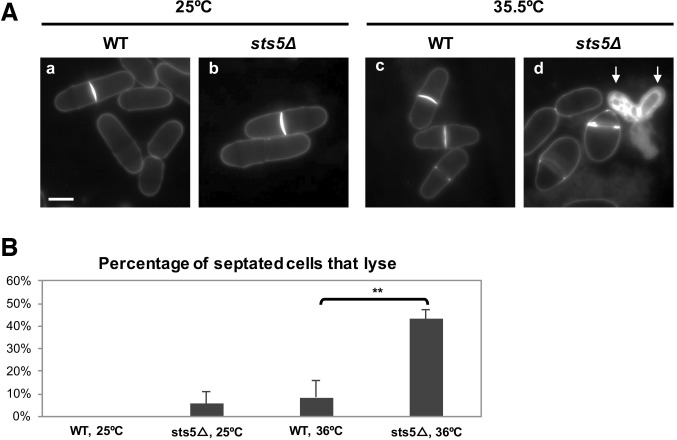
sts5∆ cells display increased cell lysis during cell separation.(A) sts5∆ cells display increased cell lysis during cell separation (d) at the restrictive temperature (35.5°C). Arrows indicate sister cells that have lysed. (B) Quantification of the percentage of septated cells that lyse in WT and sts5∆ cells at 25°C and 35.5°C. Quantification based on 3 independent experiments. Percentage of septated cells that lyse is significantly greater in sts5Δ cells as compared to controls at 35.5°C (P = 0. 0.0022, Student’s t-test, N>176 cells per condition). When comparing WT and sts5∆ cells 25°C, P = 0.1583 (Student’s t-test).